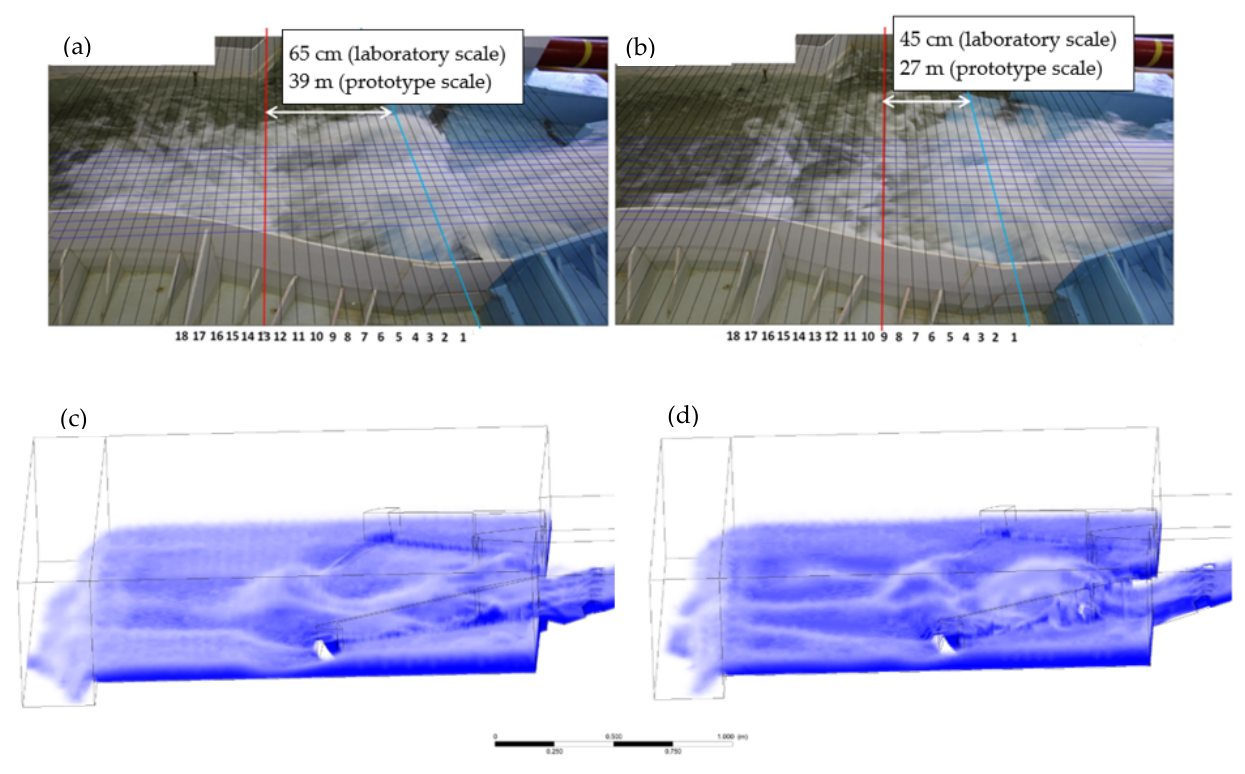
Figure 17. Hydrodynamics in the stilling basin and the riverbed downstream from the lateral view for a discharge value of 1650 m 3 /s and ( a ) ski-jump-like sill in place ( c ) is the output of the numerical model); and ( b ) ski-jump-like sill removed ( d ) is the output of the numerical model).